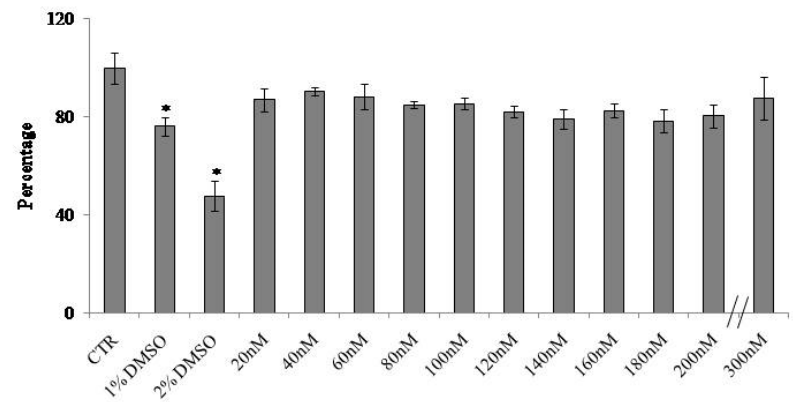
Figure 1. Effect of 25-dihydroxyvitamin D 3 (VD3) on HaCaT cell viability. Cells were cultured with increasing doses of VD3 from 20 to 300 nM for 24 h, and the viability was measured by MTT assay. Values are reported as percentage viability of the control sample; 1% DMSO and 2% DMSO were used as positive controls. Data are expressed as mean ± SD of three independent experiments performed in duplicate. Significance, * p < 0.001 versus the control sample.